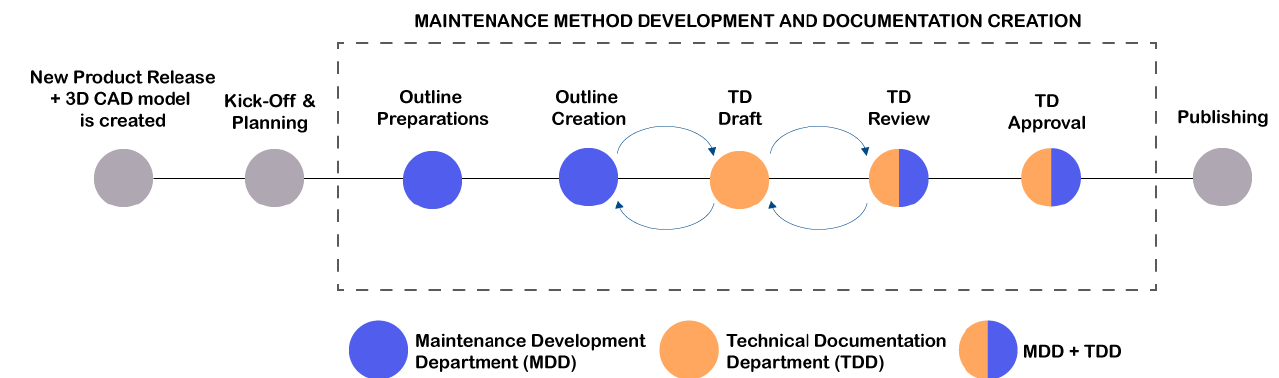
Figure 2. The process of maintenance method development and documentation creation at KONE.